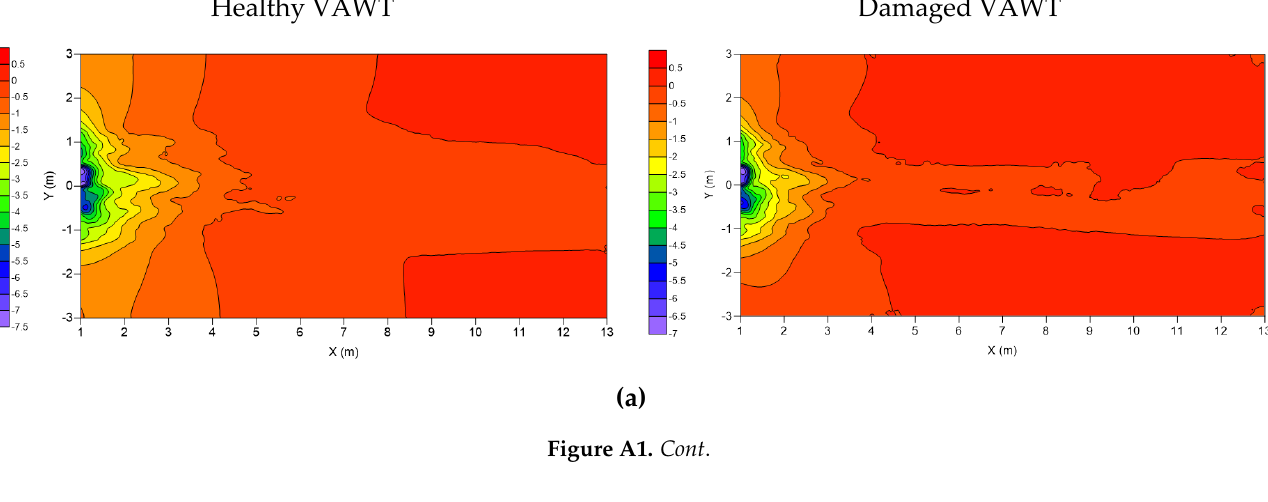
(c) Figure A1. Time-averaged spatial distribution of ( a ) pressure ( b ) velocity and ( c ) vorticity fields for the healthy and dam- aged VAWTs.